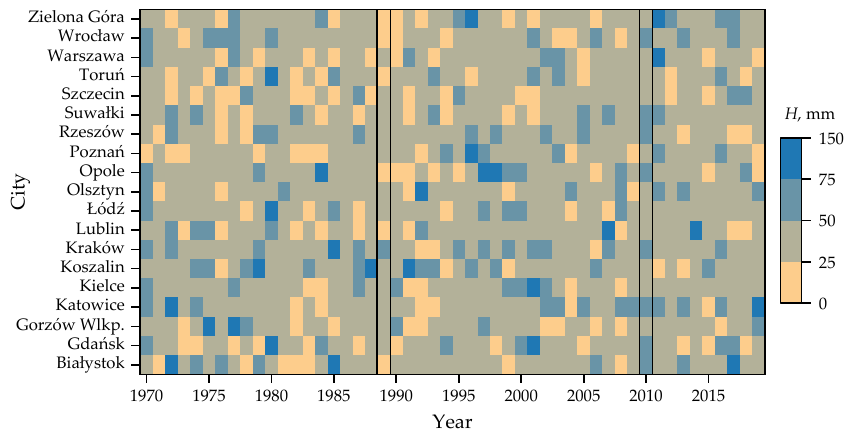
Table 1. Analysis of the daily precipitations between 1970 and 2019.